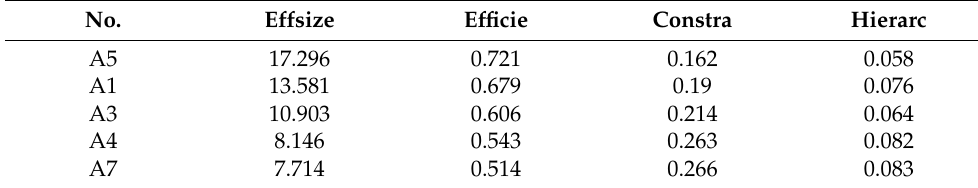
Table 4. Results of structural hole analysis (top five).